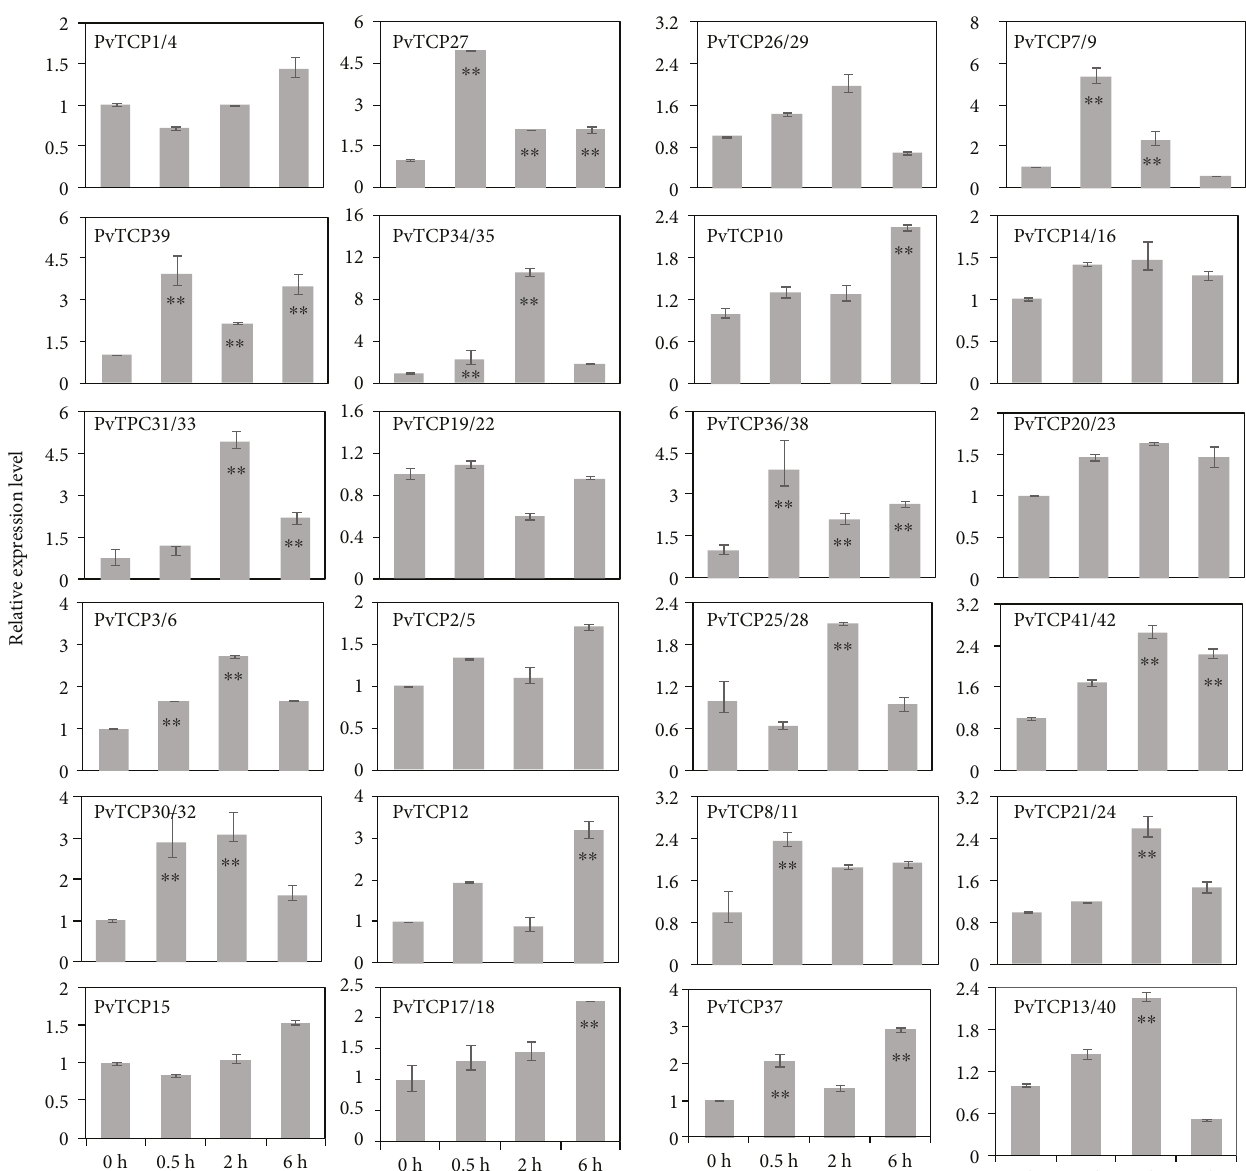
Figure 7: The expression of PvTCP genes in response to treatment with 250 mM NaCl for 0.5, 2, and 6 hours in seedlings. Control plants were collected before the treatment by NaCl solution. Error bars represented variability of three independent replicates. Statistically signi fi cant di ff erences were assessed using Student ’ s t -tests ( ∗∗ represented p ≤ 0 01